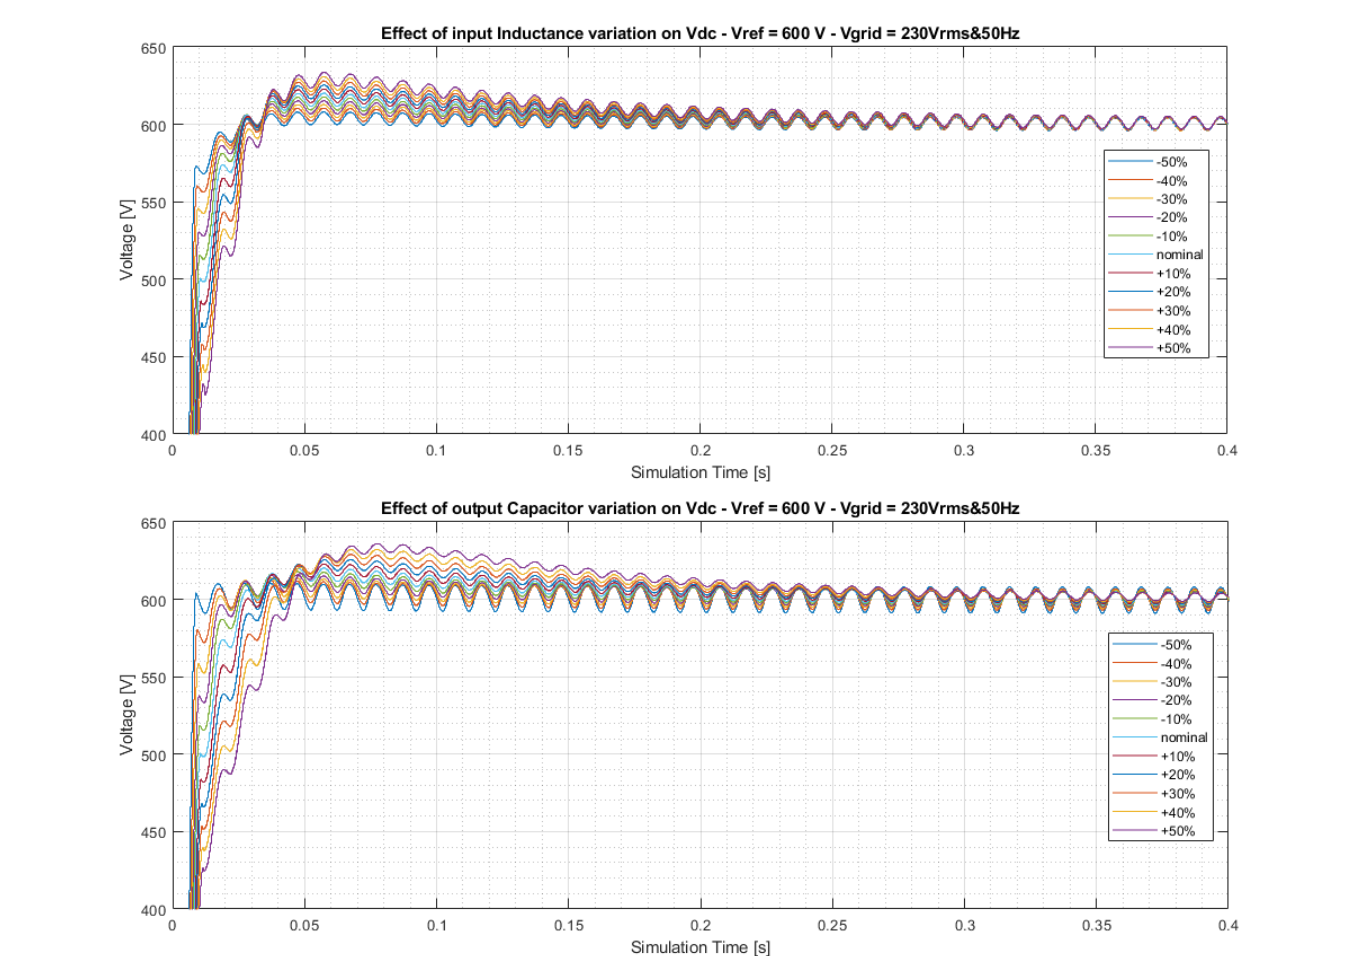
Figure 20. Voltage control robustness analysis of Totem Pole: effect of L variation ( upper ); effect of C variation ( lower